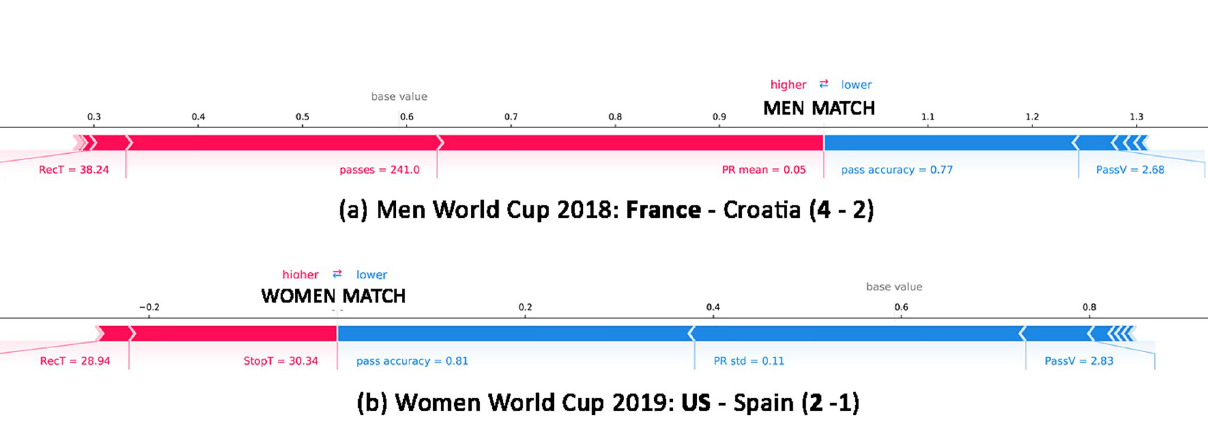
PLOS ONE | https://doi.org/10.1371/journal.pone.0255407 August 4, 2021 13 /